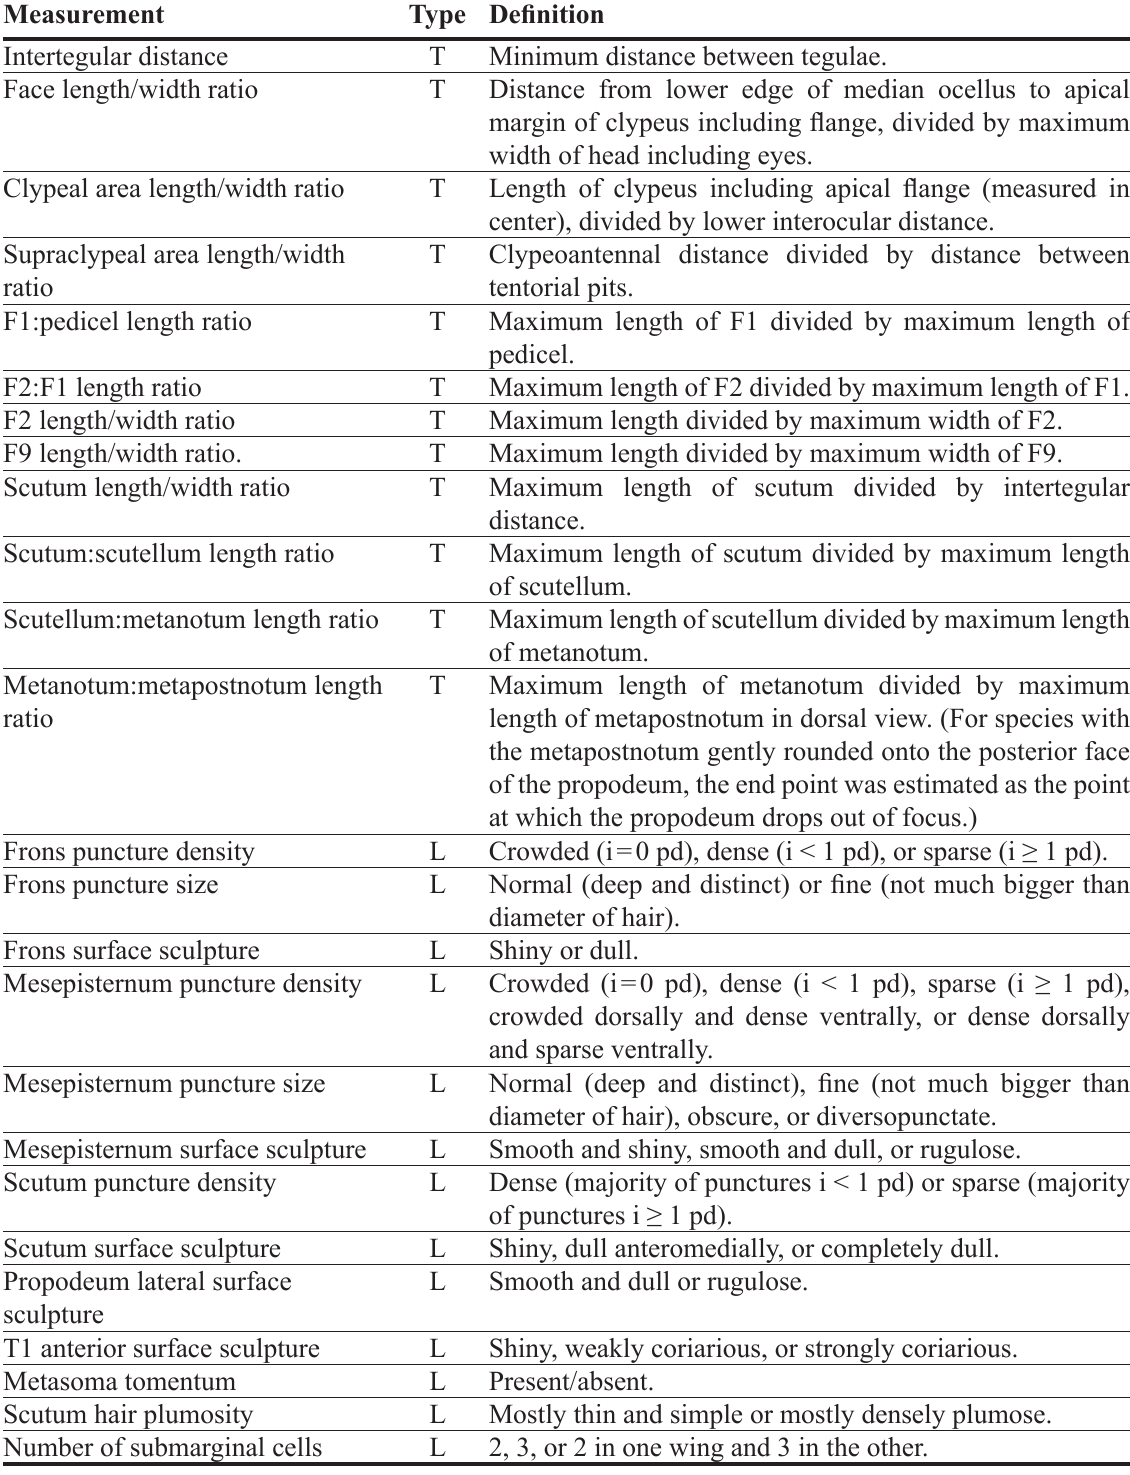
Table 1. Morphometric measurements used in species descriptions and their definitions. Type ‘T’ characters are quantitative and were used in all analyses; type ‘L’ characters are qualitative and were only used in PAM clustering with Gower distance